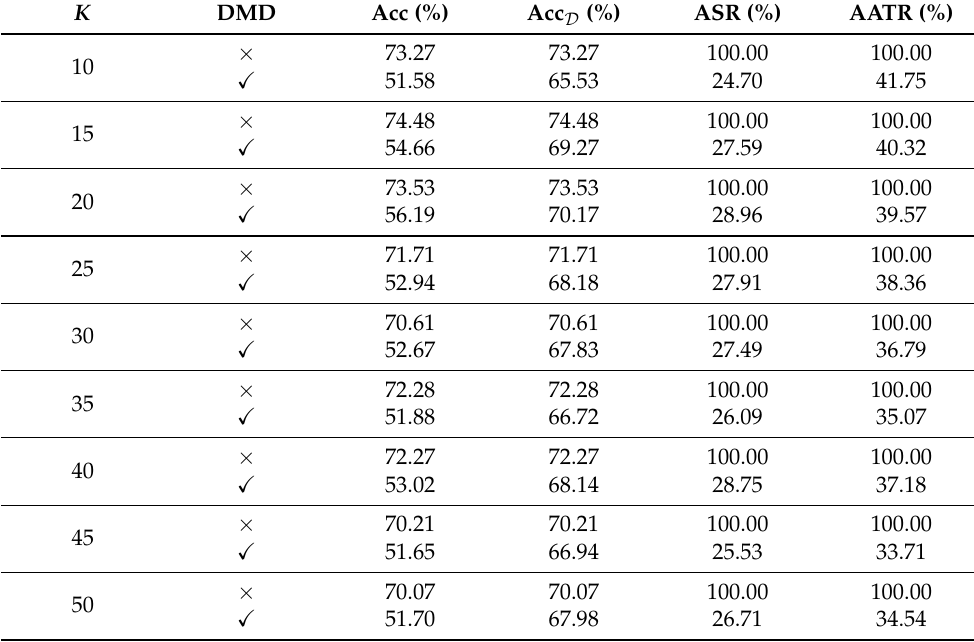
Table 2. Results of FL with/without DMD under different settings for